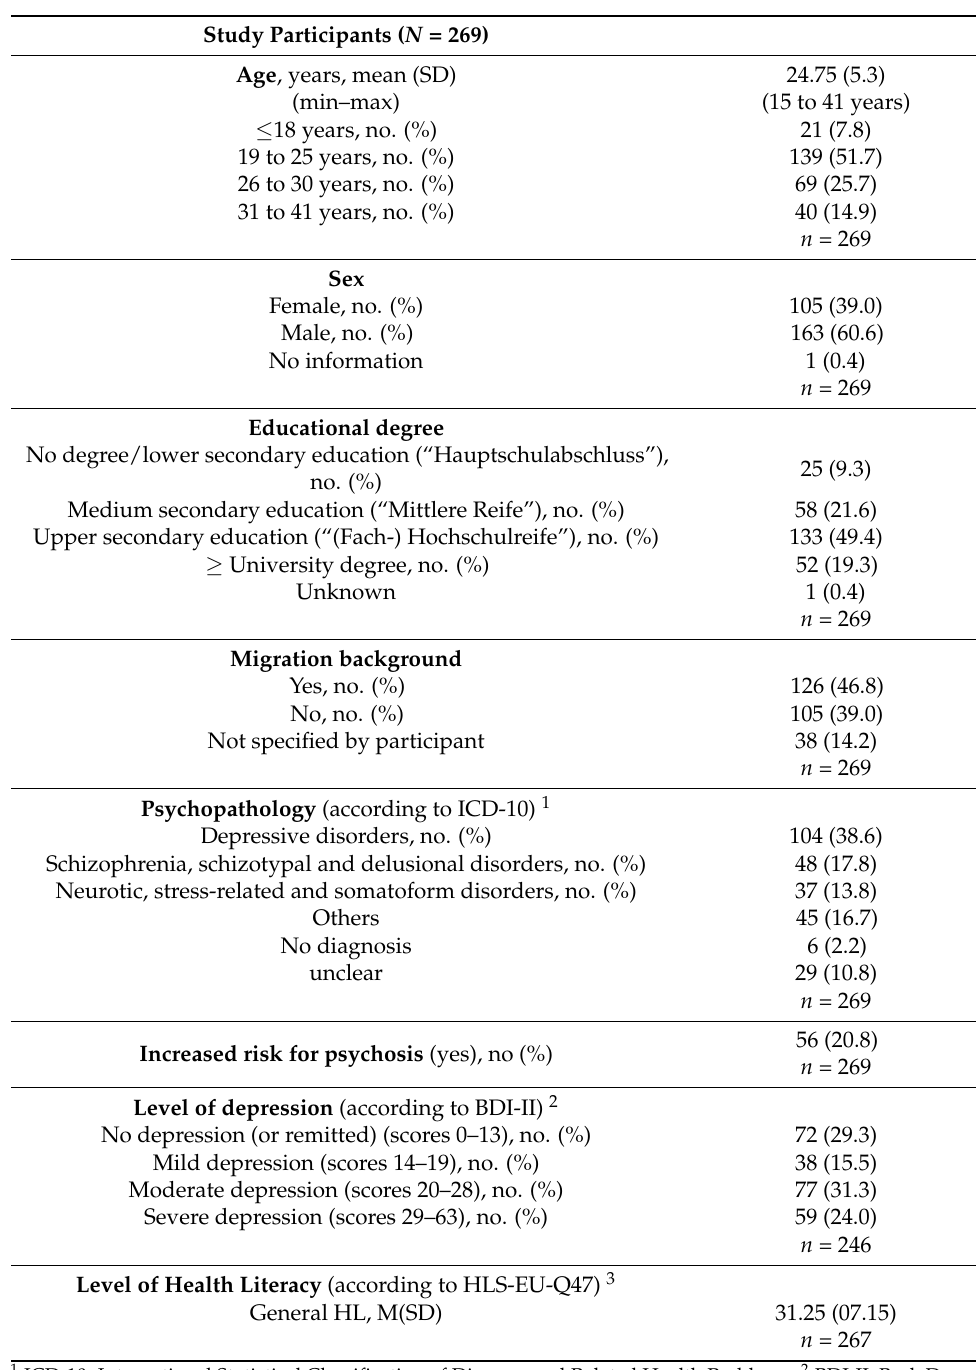
Table 1. Characteristics of study